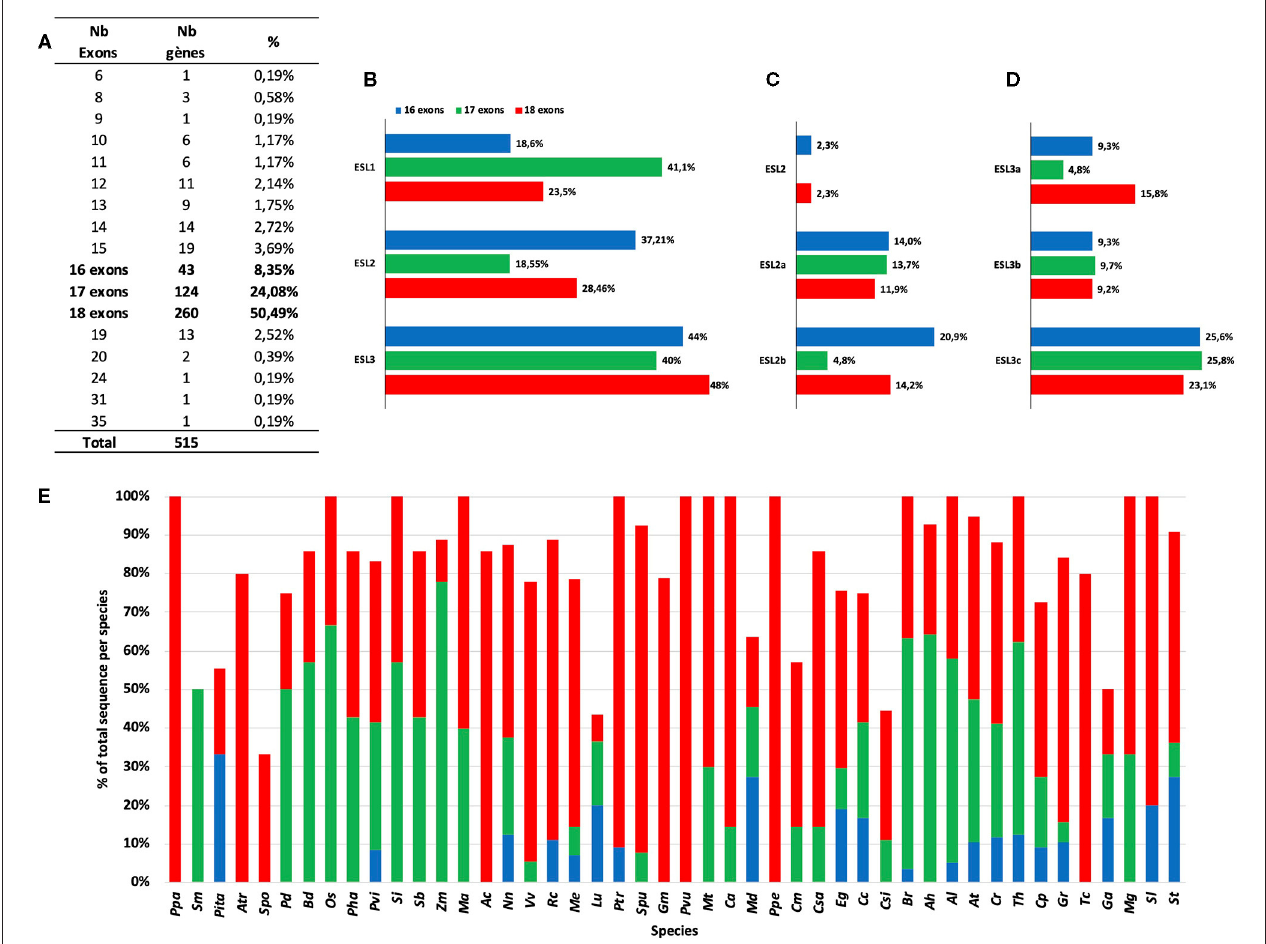
FIGURE 8 | The percentage and the distribution of the different ESL gene structures (exons–introns). (A) The gene number per structure and the percentage of total ESL . (B) The distribution of the three main structures in the three ESL groups (% is related to the number of ESL having the same type of structure and belonging to the same ESL group). (C) Distribution amount of the ESL2 group. (D) Distribution amount of the ESL3 group. (E) The percentage of each type of structure per